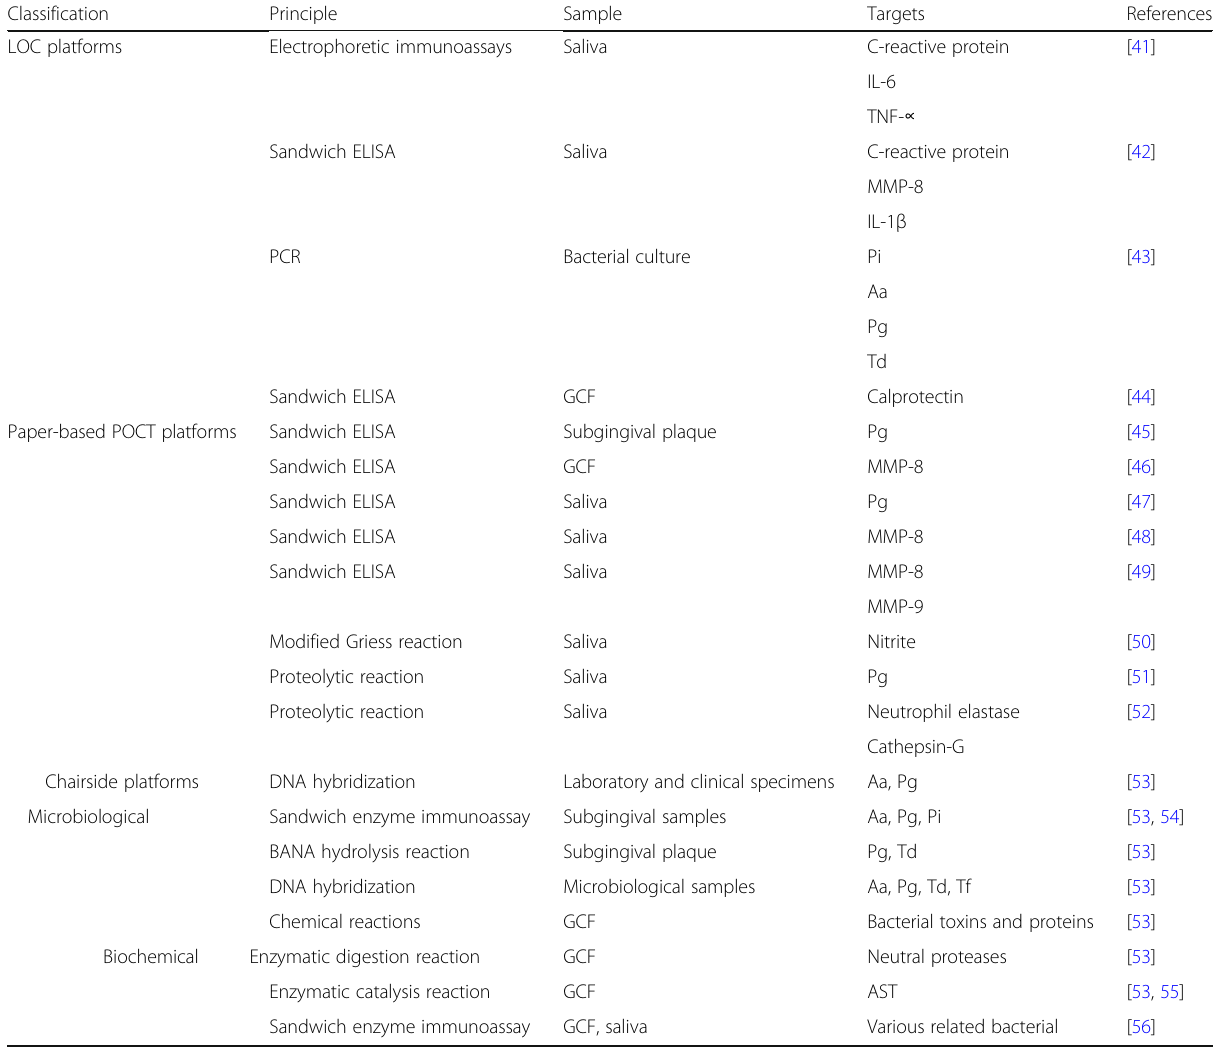
Table 3 Various principle and targets in LOC platforms, paper-based platforms, and chairside platforms for periodontitis diagnosis